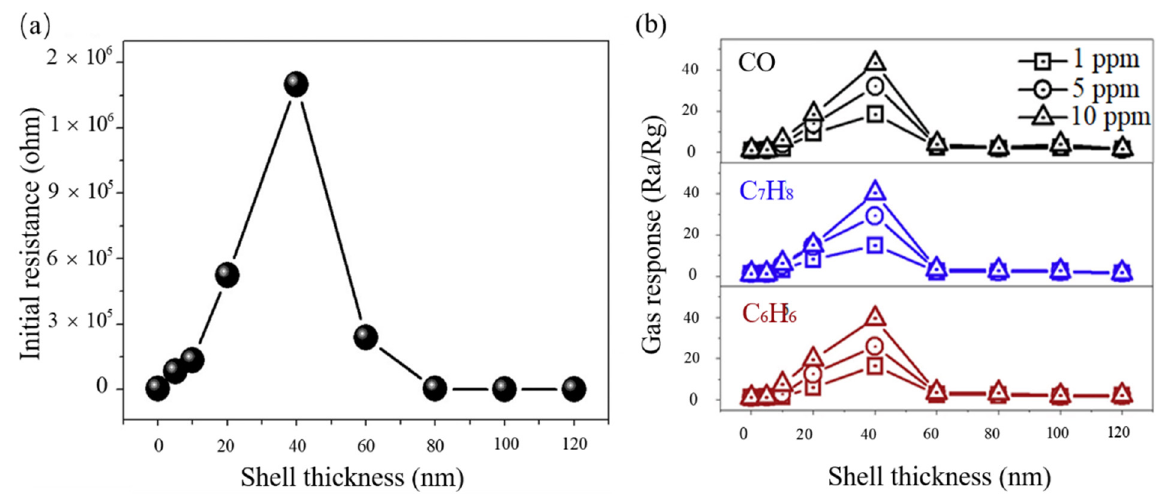
Figure 5. The influence of shell thickness of sensor response. Reprinted from [77] copyright (2020), with permission from Elsevier. ( a ) Relationship between the Initial resistance and the shell thickness; ( b ) The dynamic curve of gas response with shell thickness.